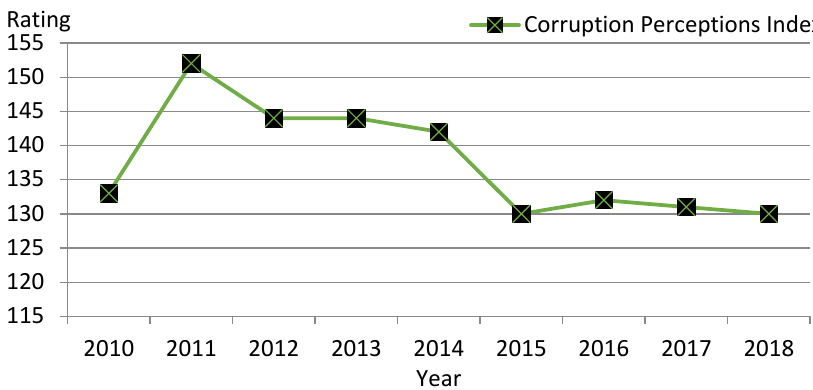
Fig. 4: The Corruption Perceptions Index of Ukraine (UIR, 2019)